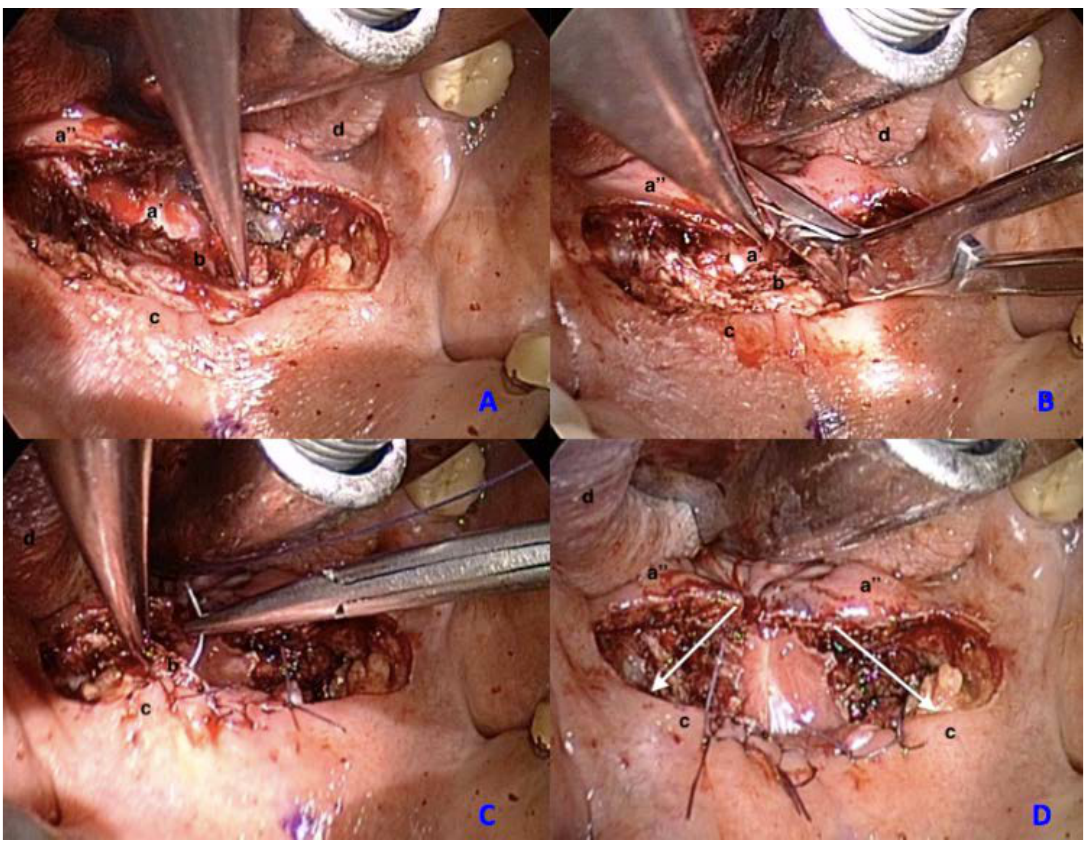
Figure 2. Surgical steps: dissection of muscular layer ( A ), splitting of nasopharyngeal mucosal flap ( B ), suture of the muscular layer to the oral mucosal layer ( C ), eversion of the left and right palatal flaps anteriorly and laterally ( D ). a’—nasopharyngeal mucosa inner face, a”—nasopharyngeal mucosa external face, b—muscular layer, c—oral mucosal layer, d—tongue.